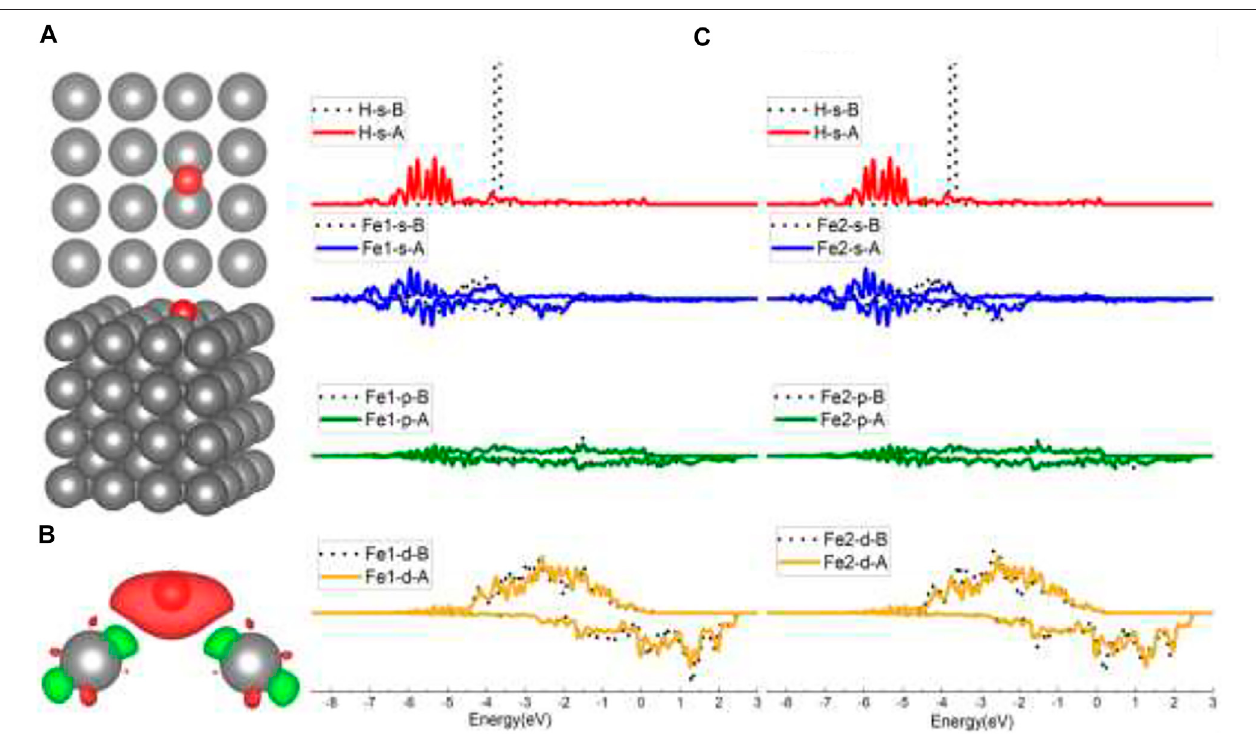
FIGURE 3 | The optimized structure, charge density difference, and density of state (DOS) of the top site after the hydrogen atom is adsorbed on the Fe (100) surface: (A) top and side view of the H-slab structure (hereinafter dark grey atoms are Fe and red atoms are H), (B) charge density difference (the isosurface of charge difference is 0.007 electrons/Bohr 3 ), red color represents charge accumulation, and green color represents charge depletion, and (C) density of state (DOS) before and after H atom adsorption, the black dotted lines represent s / p / d orbitals before H adsorption, and B/A represents before and after, respectively.